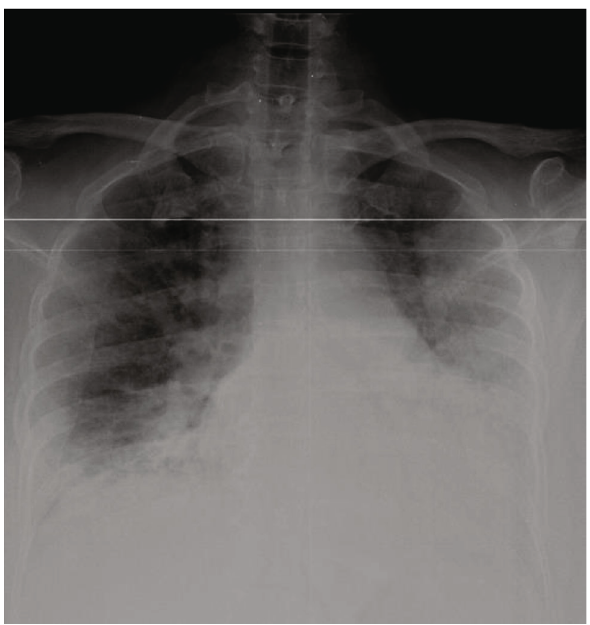
Figure 3: Chest radiograph of case 2 on the day of admission with silent hypoxaemia showing bilateral lower zonal opaci fi cation. There is more involvement on the left side.